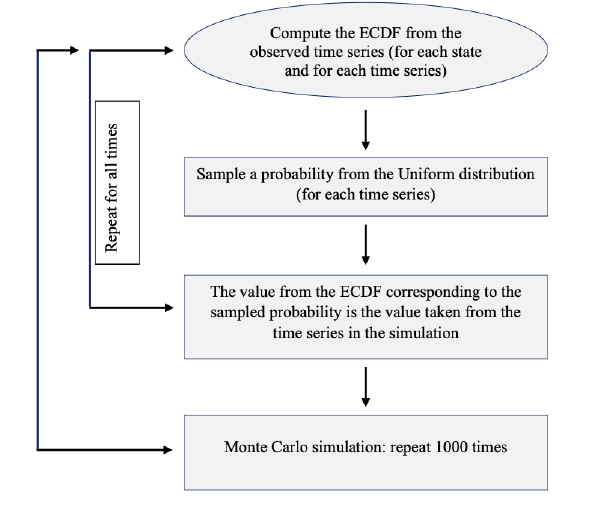
Figure 10. The algorithm that associates a real value to the categorical state occupied by the process.